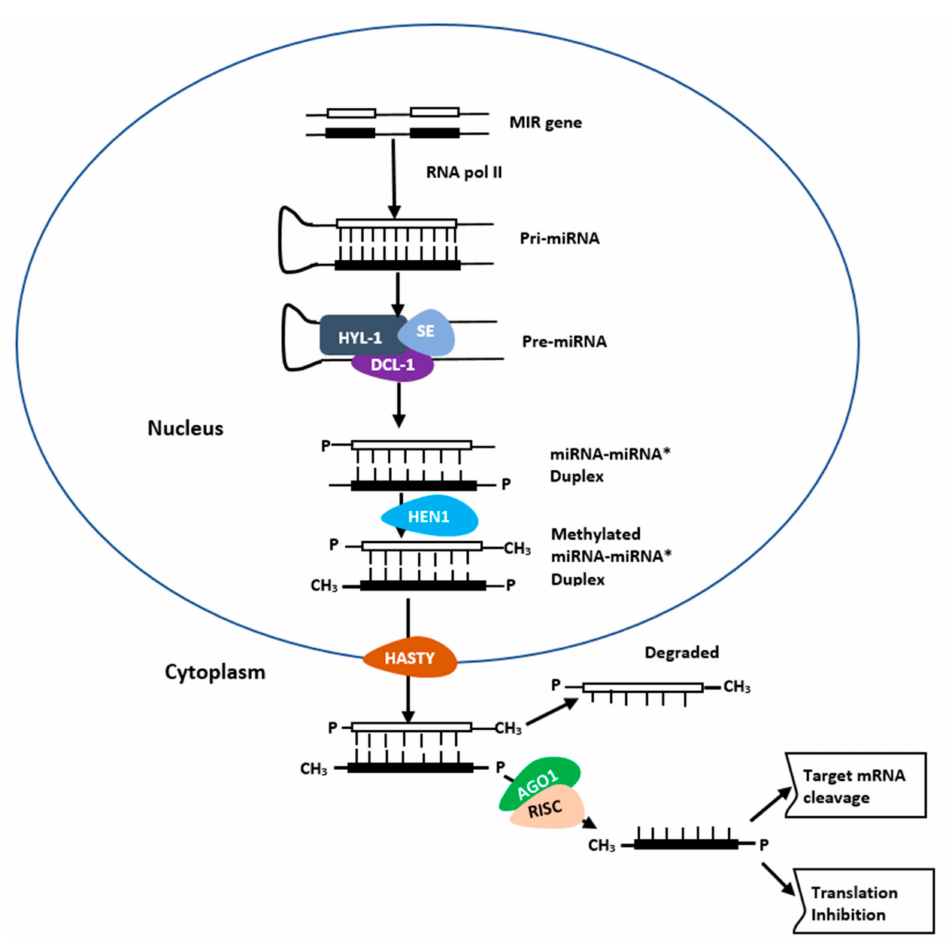
Figure 2. Biogenesis of plant miRNAs. In the nucleus, MIR genes are processed to miRNA / miRNA* duplexes through the action of Pol II, DCL1, SE, HYL1, HEN1, and HASTY. In the cytoplasm, the duplex is incorporated with RISC-AGO complex to which guides it towards the target, resulting in suppression of the translation and cleavage of